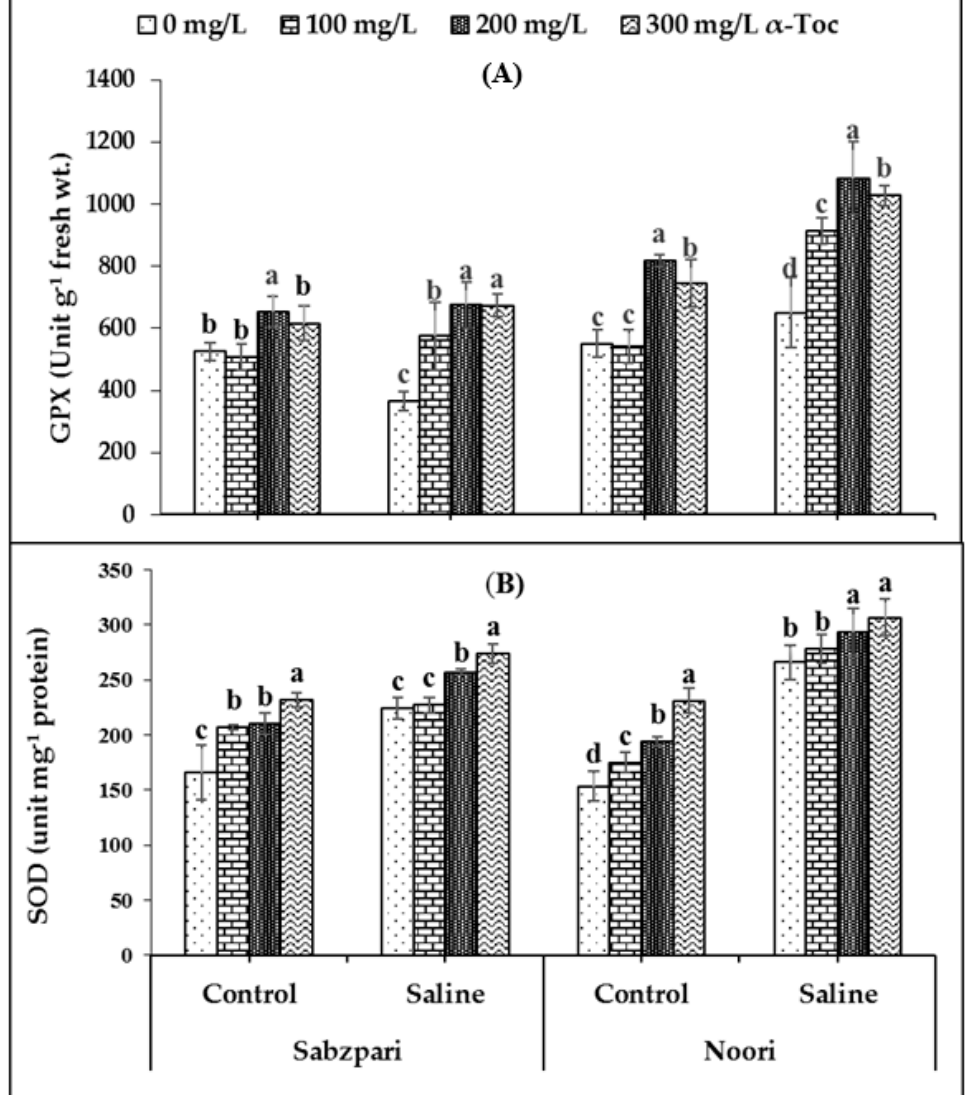
Figure 2. Effect of different levels of α -Toc under saline and non-saline conditions on ( A ) activities of guaiacol peroxidase (GPX) and ( B ) superoxide dismutase (SOD) of okra varieties. Values represent means ± S.D. Significant differences among row spacing were measured by the least significant difference (LSD) at p > 0.05 and indicated by different letters. S.D. stands for standard devia- tion.